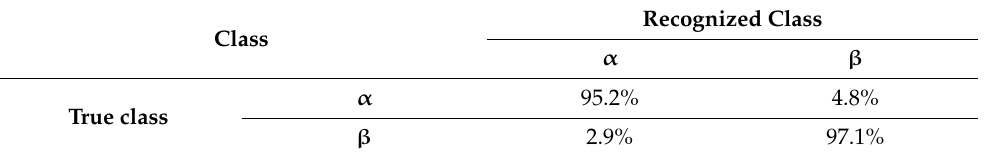
Table 1. Error matrix corresponding to the k-nearest neighbors method